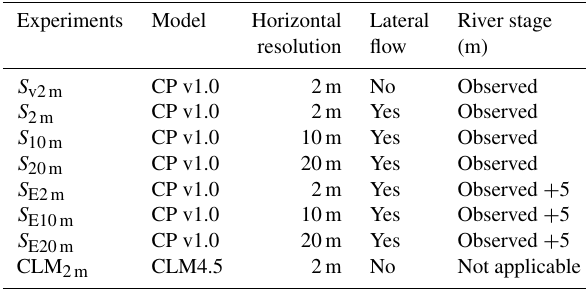
Table 1. Summary of numerical